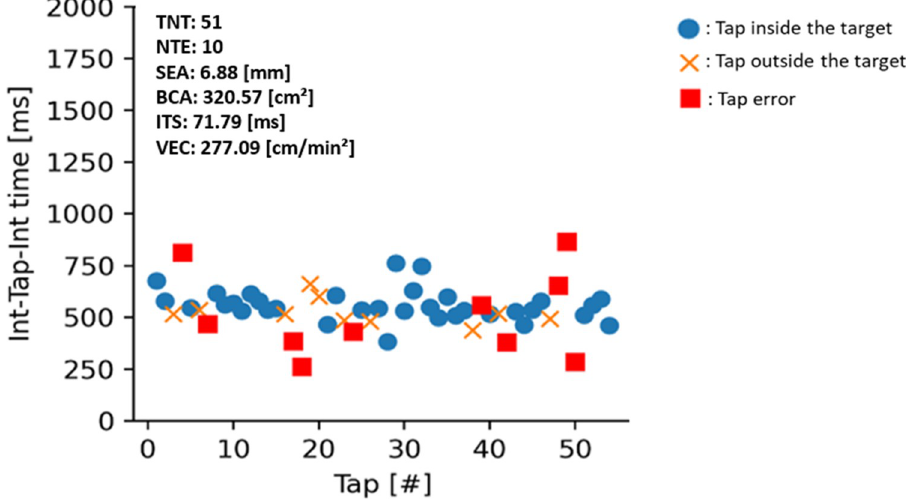
Fig 3. Data output example. Abbreviations: TNT = Total Number of Taps; NTE = Number of Tapping Errors; SEA = Spatial Error: Mean; BCA = Bivariate Contour Ellipse Area; ITS = Inter Tap Interval: Standard Deviation; VEC = Velocity: